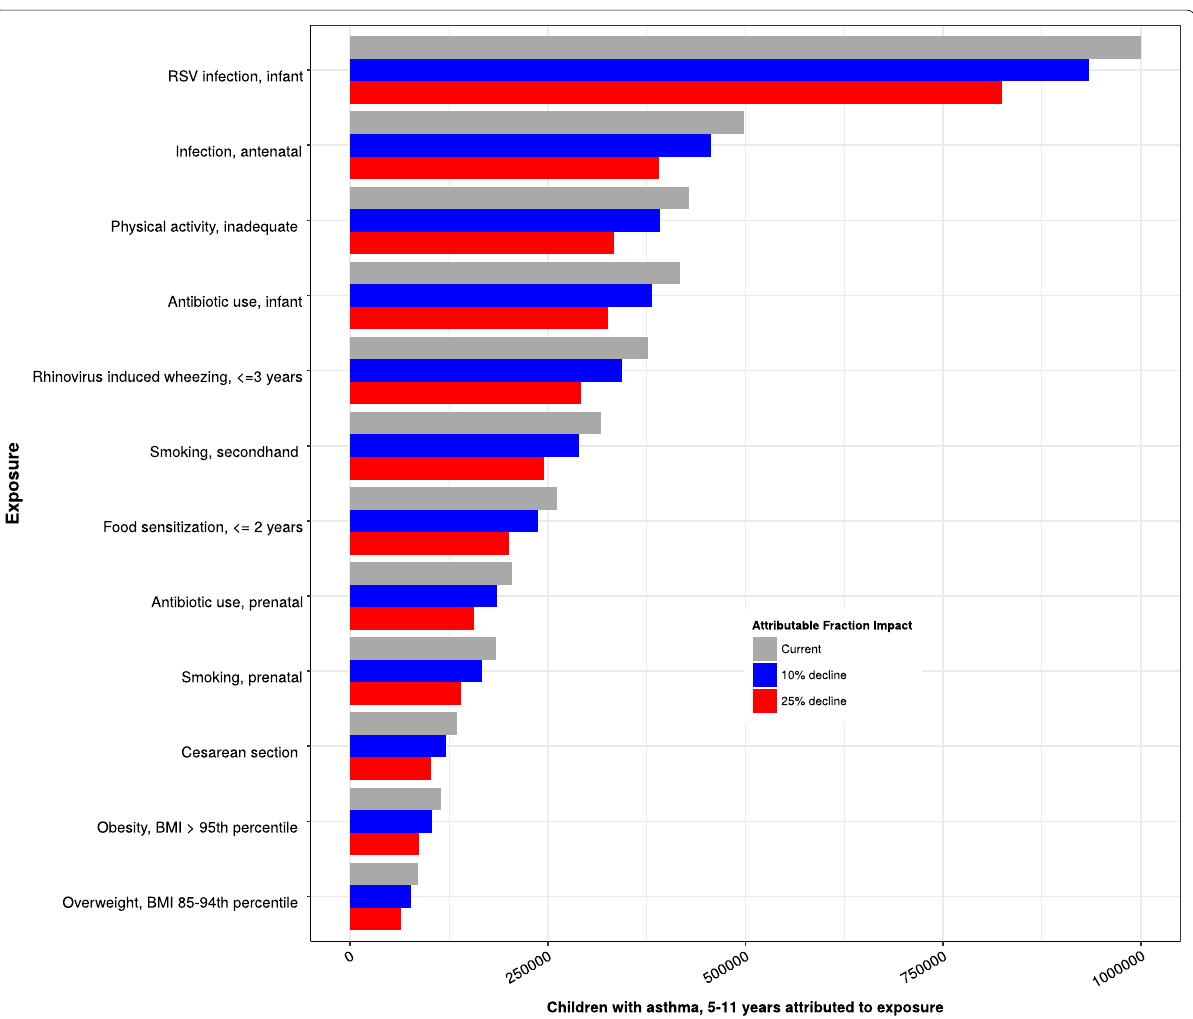
Fig. 3 Impact of reducing selected risk factor exposure on asthma cases among children 5–11 years of age. Based on an asthma prevalence of 9.6% from the Centers for Disease Control and Prevention to estimate 2,761,000 children with asthma. Twelve risk factors were selected for ranking based on their effect size, prevalence of exposure, and potential for modification. This figure considers only the main effect of the risk factor (without accounting for potential